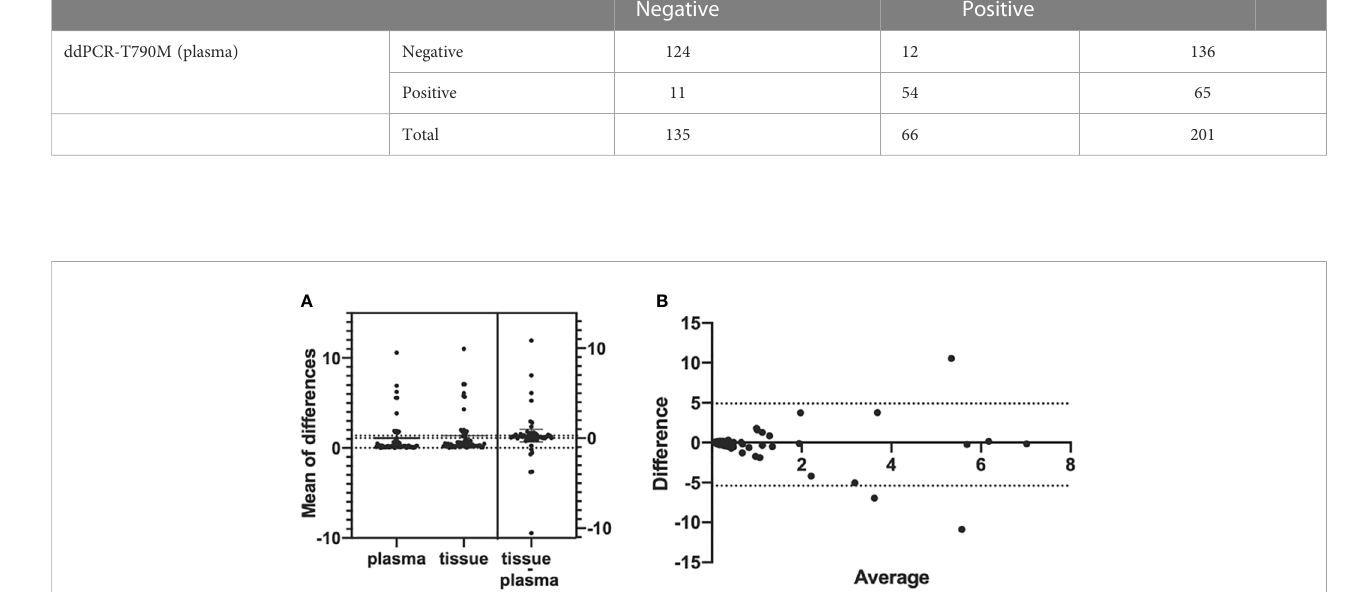
FIGURE 2 Bland – Altman agreement plots of T790M abundance detected in plasma and tumor tissues by ddPCR. (A) Mean of the differences of 54 T790M-positive samples ’ mutation abundance in both plasma samples and tumor tissue samples; P -value >0.05, no signi fi cance. (B) The Bland – Altman bias of differences between plasma samples and tumor tissue samples detected EGFR T790M abundance.